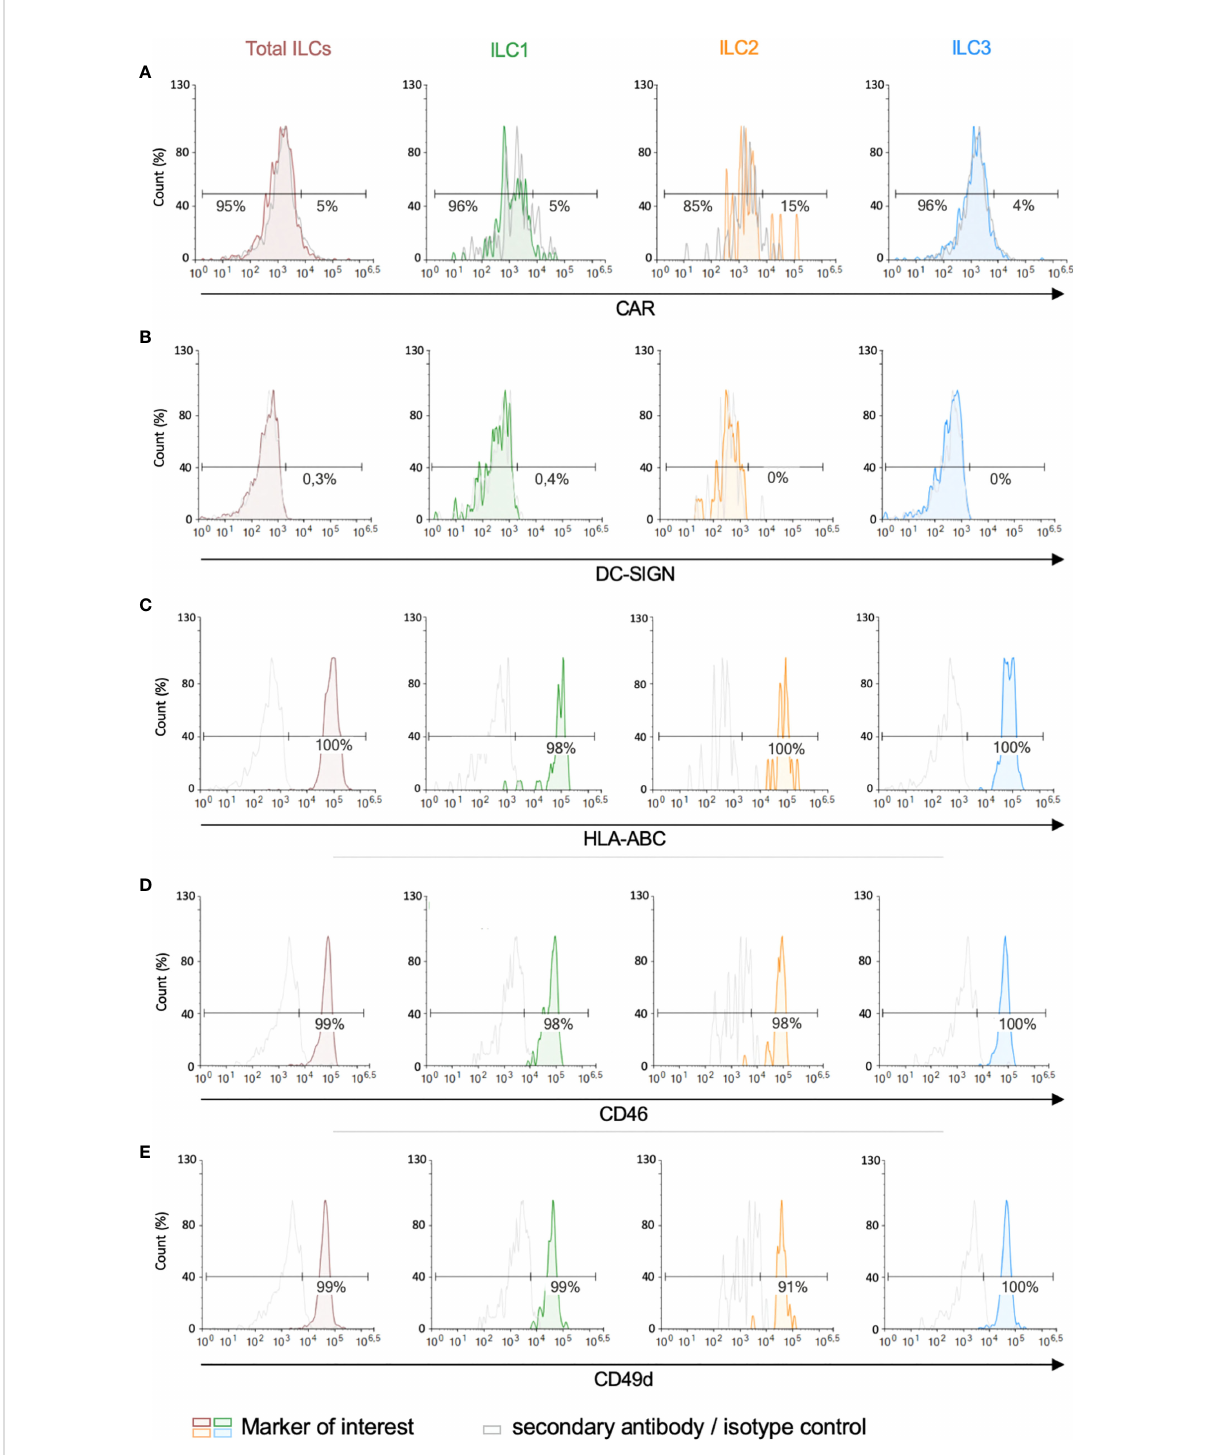
FIGURE 3 Expression of candidate HAdV receptors by human peripheral blood ILCs. Levels of (A) CAR, (B) DC-SIGN, (C) HLA-ABC (MHC-I), (D) CD46, and (E) CD49d, in freshly isolated total ILCs, ILC1, ILC2 and ILC3. Cell populations were normalised to 100%. Data are representative of 2 - 4